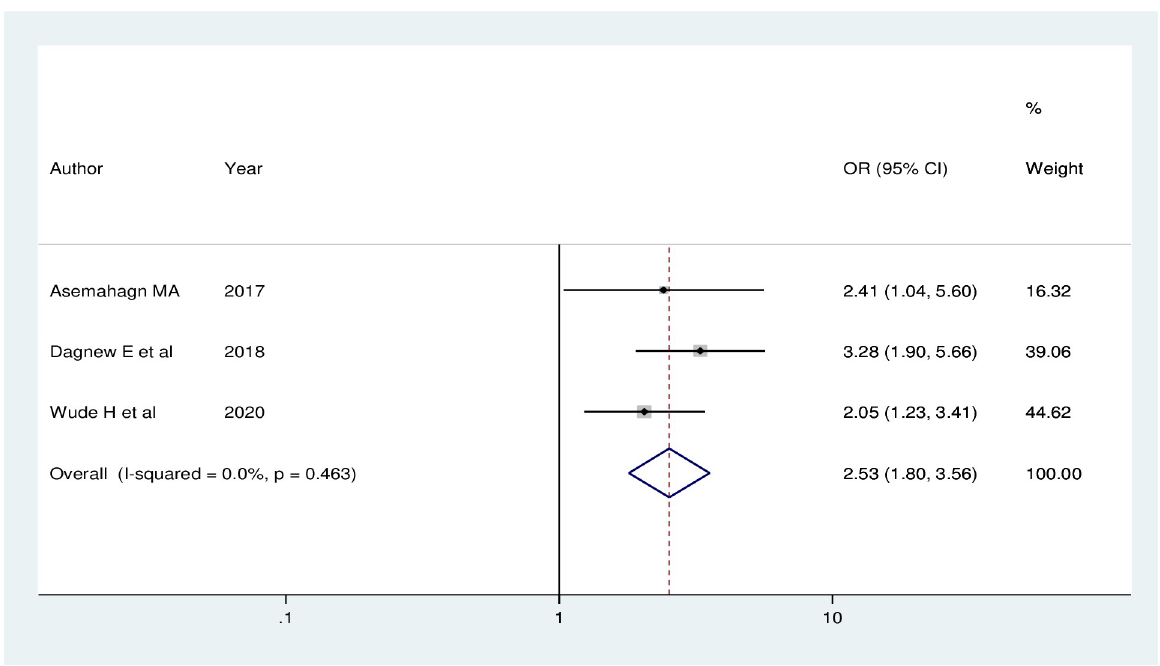
Fig 7. Forest plot showing the pooled odds ratio of the association between availability of standard guideline and utilization of routine health information health workers in Ethiopia, 2020.